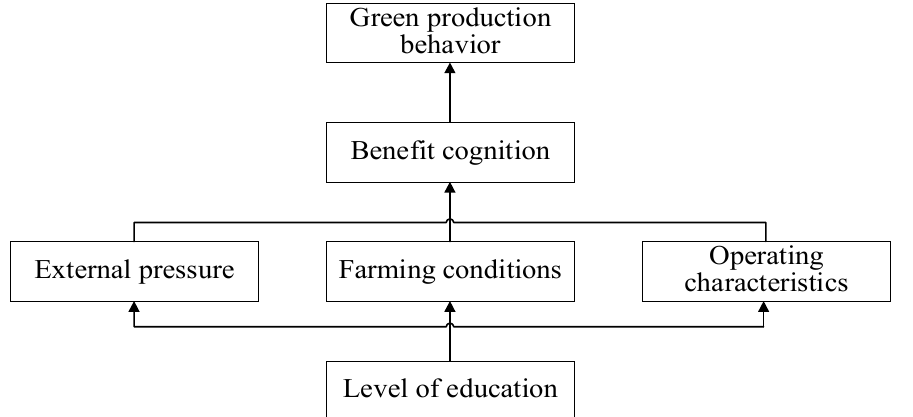
Figure 7. Correlation and Hierarchical Structure Among Influencing Factors of Green Production